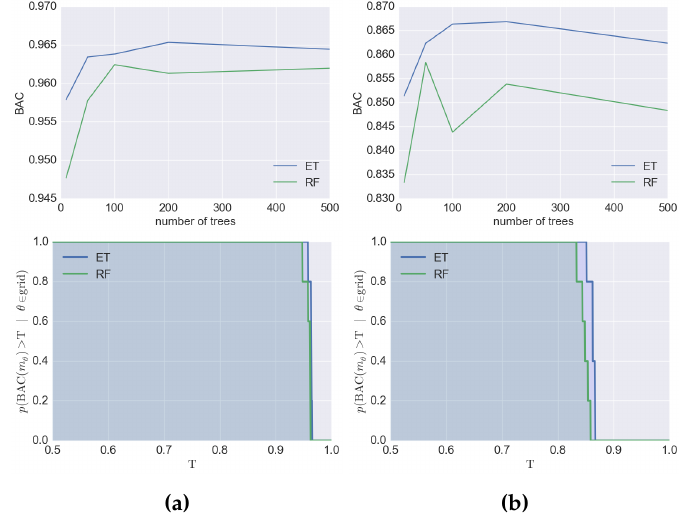
Figure 4. Visualization of the optimization procedure of ET and RF for selected datasets: ( a ) 5-HT 6 with ExtFP; ( b ) HIV i with PubchemFP. In the top row—BAC scores obtained for a particular number of trees. In the bottom row—a plot of the probabilities of obtaining at least a given BAC score (T) from a given model assuming a random selection of the number of trees from the tested